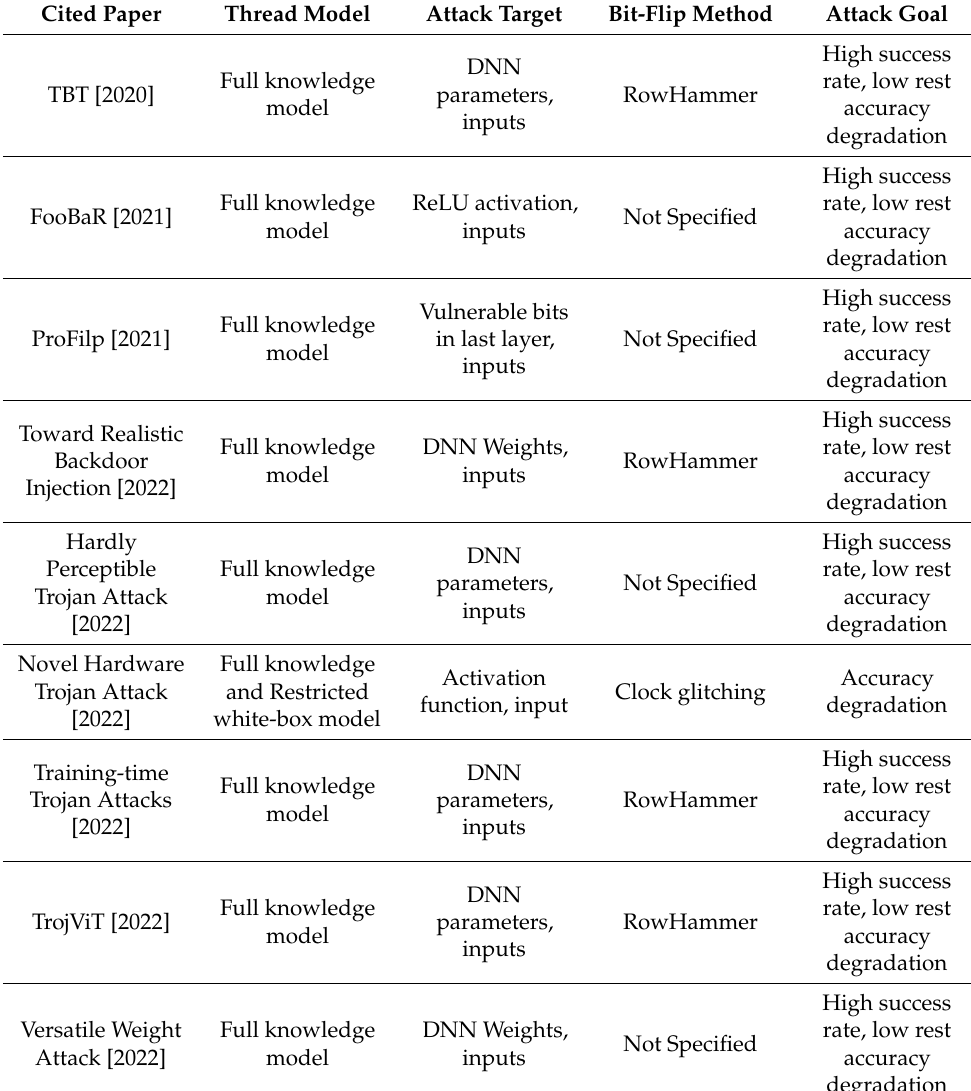
Table 4. The detailed attack aspects for bit-flip based trojan related